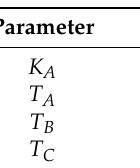
Table 3. Typical values of IEEE type AC4A excitation system.